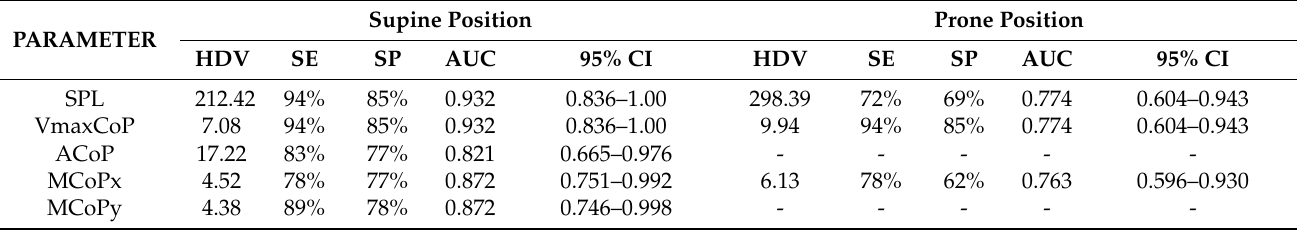
Table 5. The highest discrimination value between the tested group and the control group for individual parameters describing spontaneous sway of CoP in the supine and prone